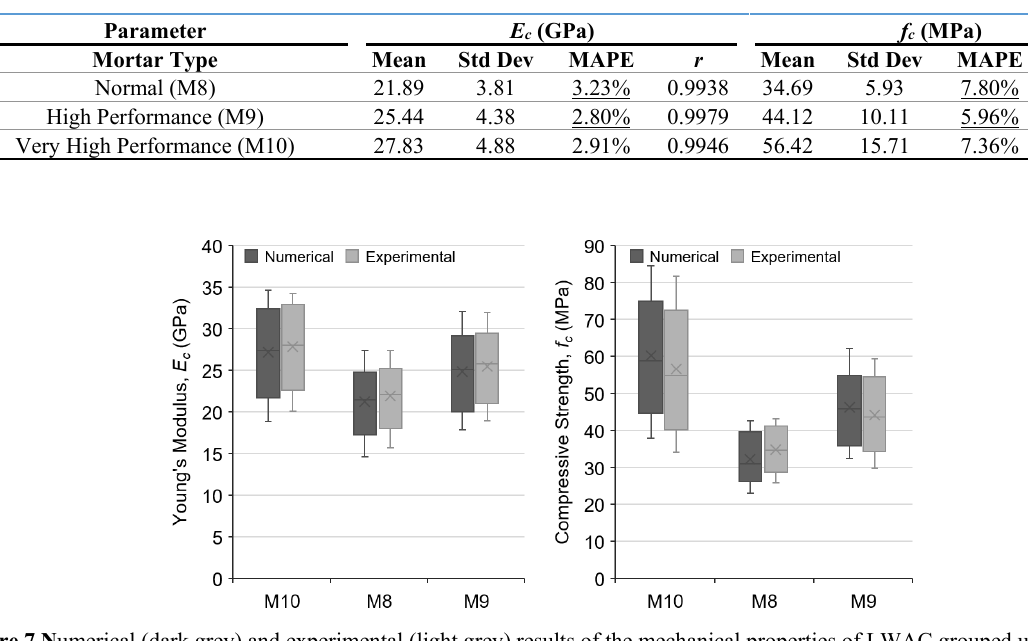
Figure 7 N umerical (dark grey) and experimental (light grey) results of the mechanical properties of LWAC grouped under mortar type (M8 - normal, M9 - high performance and M10 - very high performance): left - Young’s modulus; right - compressive